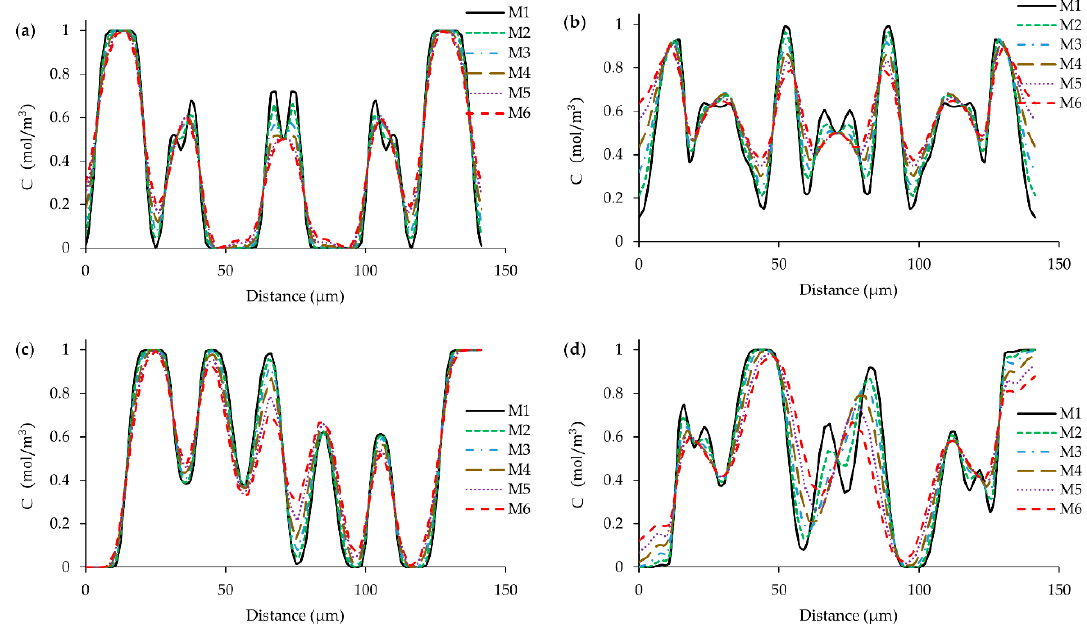
Figure 6. Grid study results for scalar transport at Re = 240: ( a ) and ( c ) concentration distribution on x-y plane at the exit of the mixing box (Line-I in Figure 3) for four-inlet and two-inlet designs respectively; ( b ) and ( d ) concentration distribution on x-y plane at z = 500 µ m (Line-II in Figure 3) for four-inlet and two-inlet designs respectively.